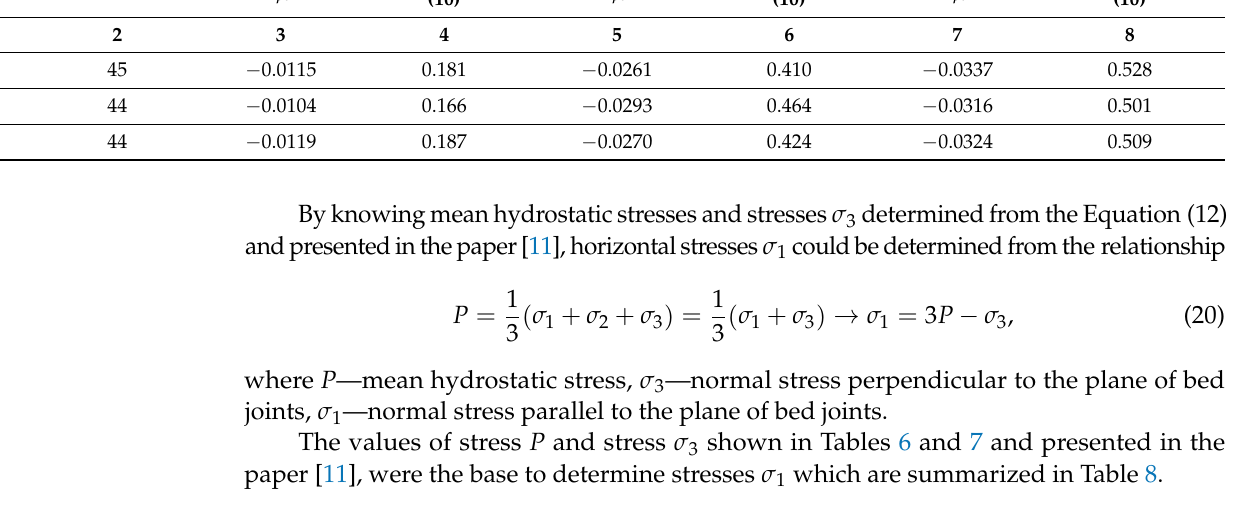
Table 8. Calculated mean stress σ 1 based on a varying number of measuring